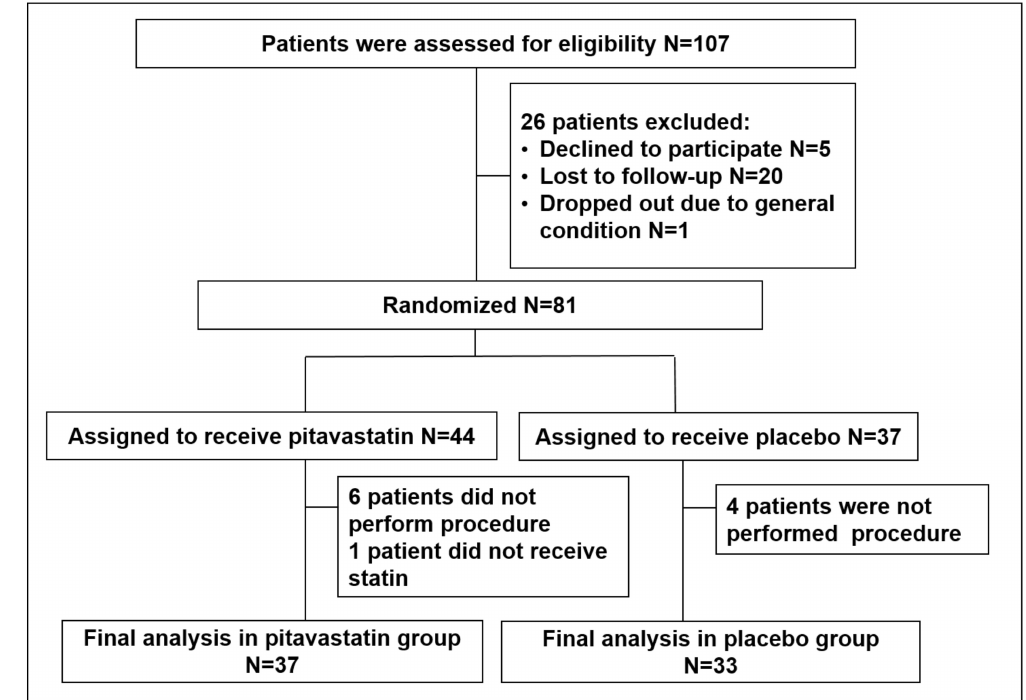
Figure 1. Patient